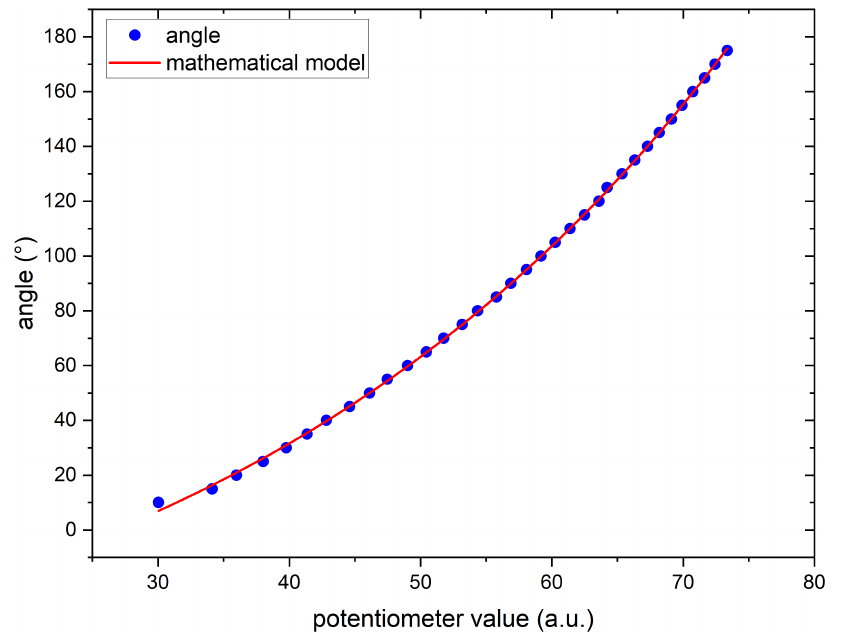
Figure 8. Theta-axis displacement measured with the goniometer as a function of a multiturn poten- tiometer: the solid line corresponds to a mathematical model obtained from physical